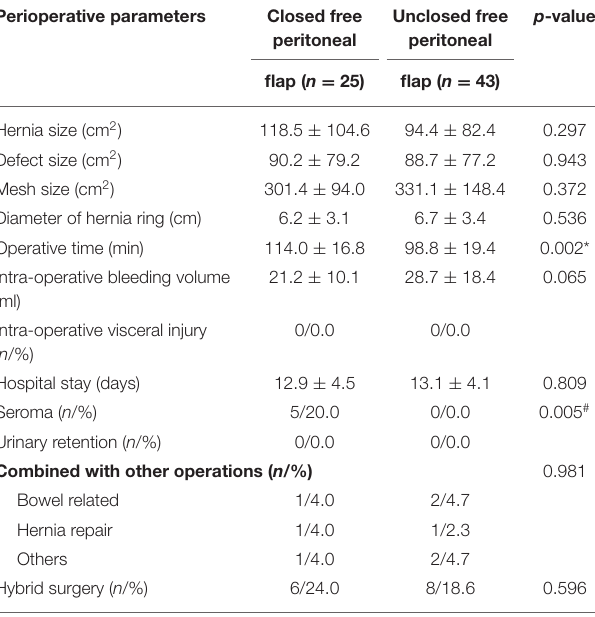
TABLE 6 | Comparison of perioperative parameters in two